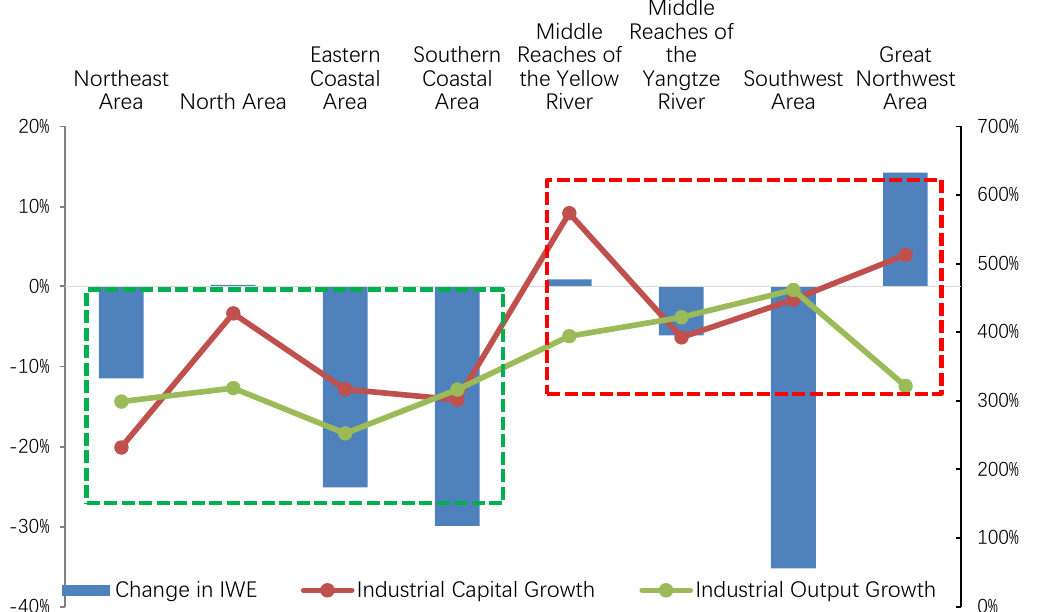
Figure 7. Changes in industrial capital and industrial wastewater emission in the eight areas, 2003–2015. IWE: industrial wastewater emission. Data resources: Annual Statistic Report on Environment in China [16] and China Statistical Yearbook [55].